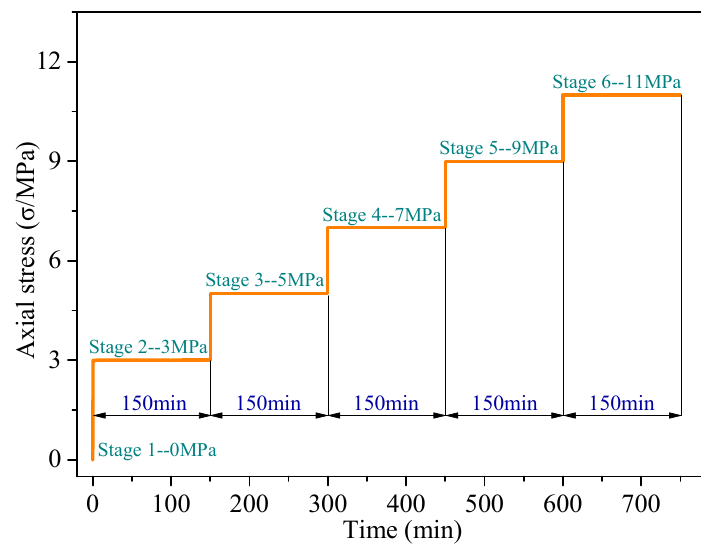
Figure 7. Test plan design of the coal sample C-1.